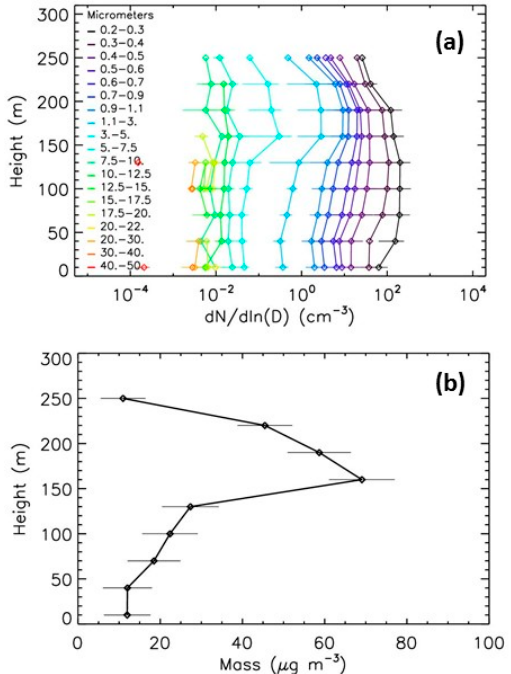
Figure 13. Evolution with height of LOAC concentrations for the 25 June 2019 pollution event. (a) number concentrations; (b) PM10 mass concentration.